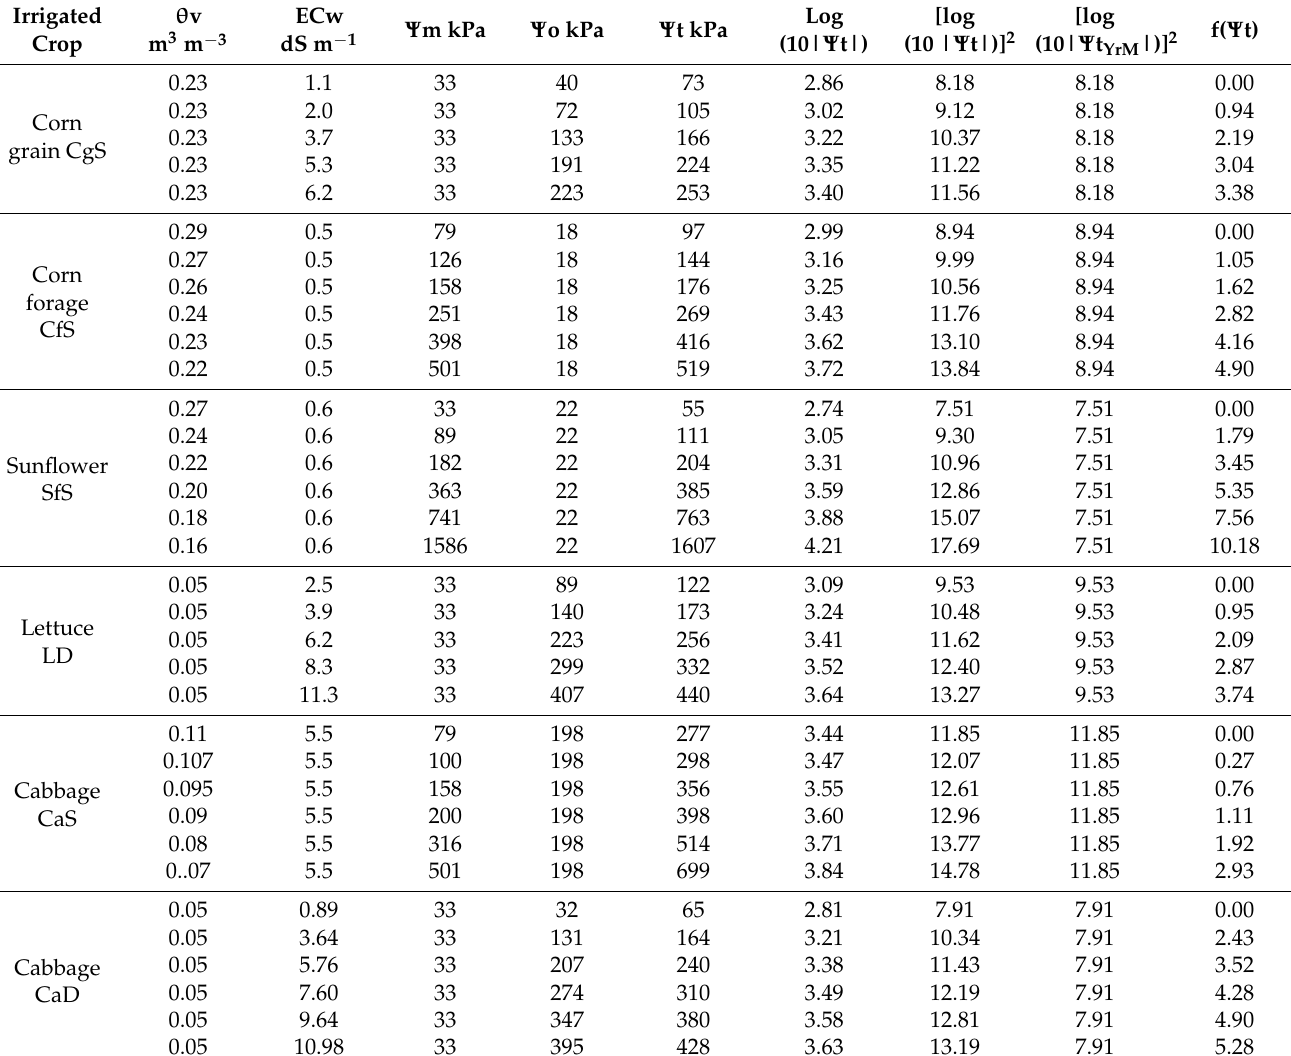
Table 5 shows the effect of both variations—soil water and salinity different levels—on the function of the soil total water potential f( Ψ t), for several other irrigated crop fields and sites. Table 5. Other irrigated crops—function soil total water potential f( Ψ t) and data needed for its calculation, according to the above